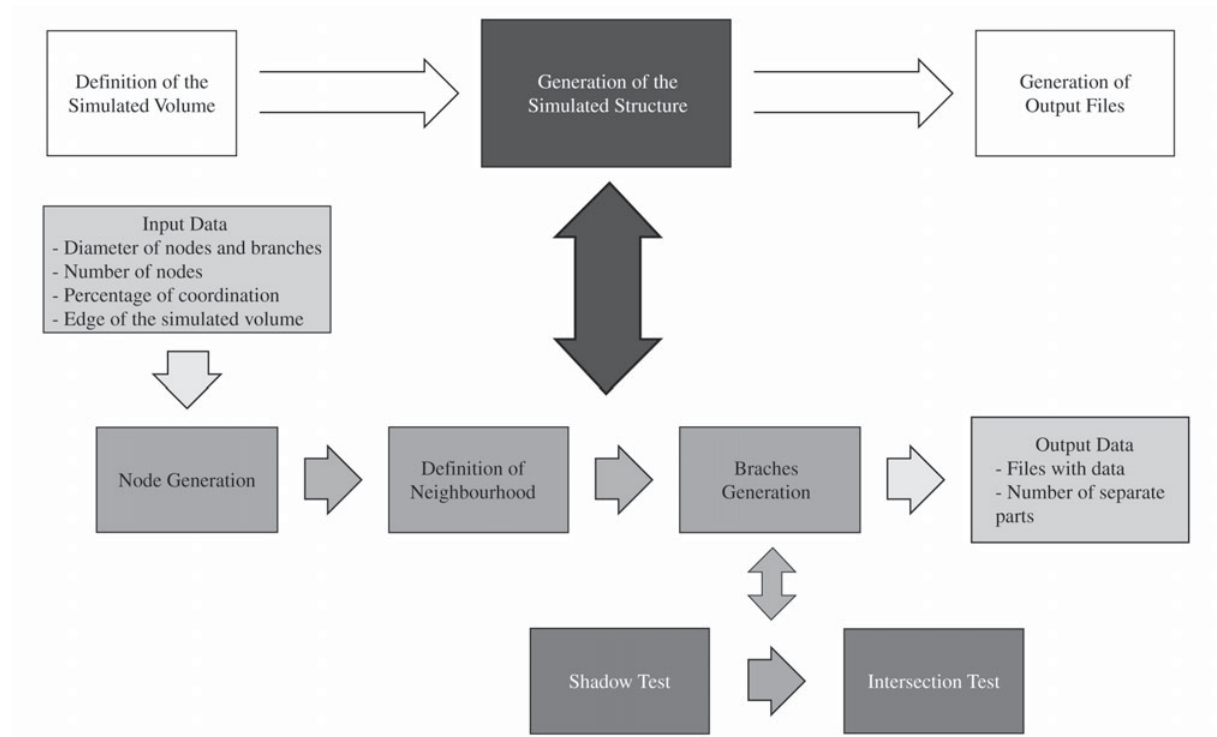
Figure 2. Detailing the stage of generating the